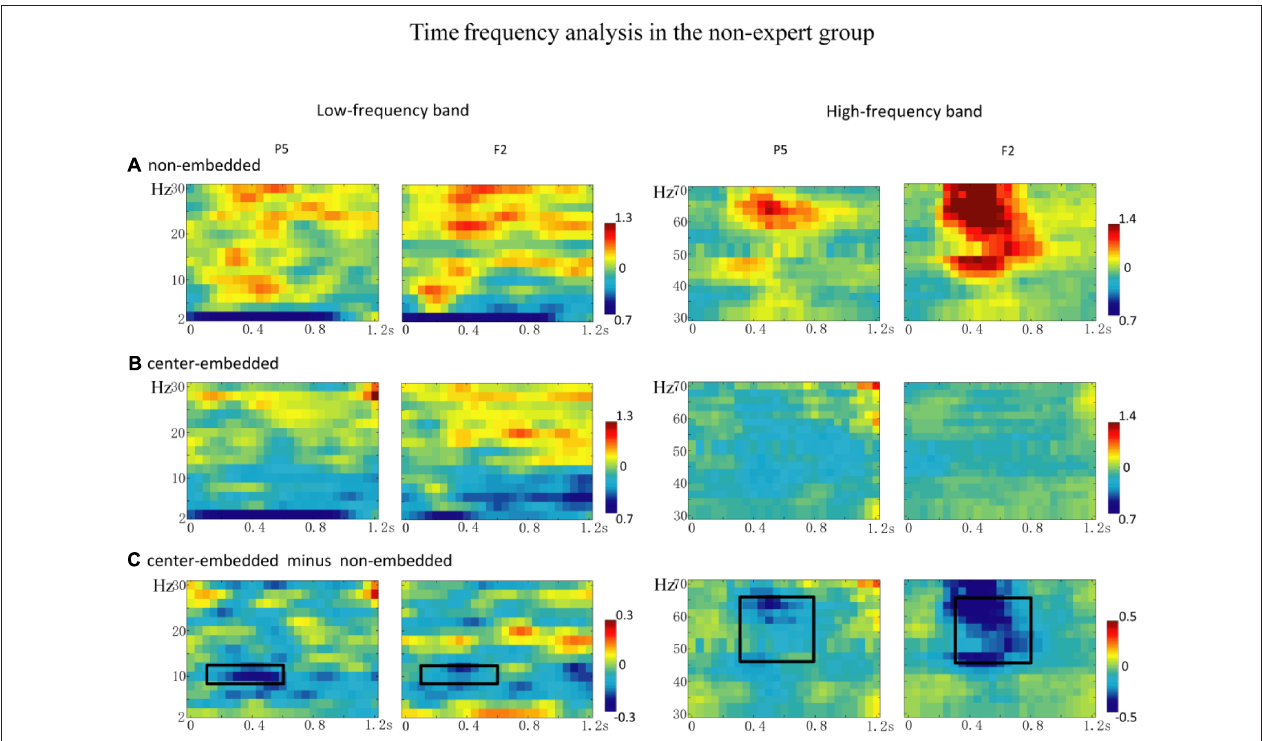
FIGURE 3 | The time frequency analysis of final chords in the non-expert group. (A,B) Time frequency representations of the non-embedded and center-embedded conditions at electrodes P5 and F2 for the low and high frequency ranges. (C) Contrasts of the center-embedded and non-embedded conditions at the same electrodes. The black boxes indicate that, at low frequency, the alpha-band power (8–12 Hz) within the selected time window (100–600 ms) was significantly different between the two conditions; at high frequency, the gamma-band power (45–65 Hz) within the selected time window (300–800 ms) was significantly different between the two